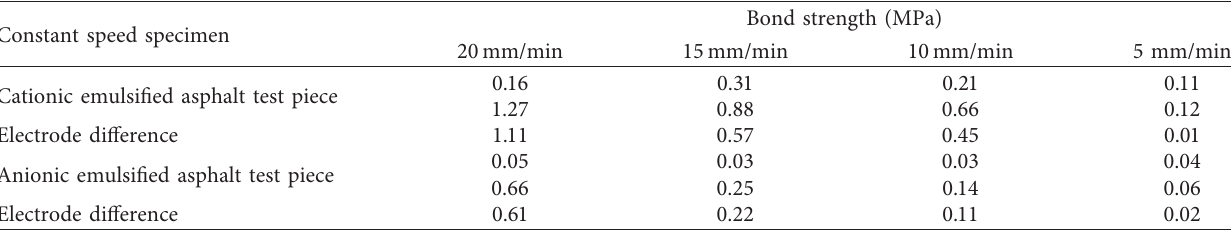
Table 6: Bond strength results under different drawing